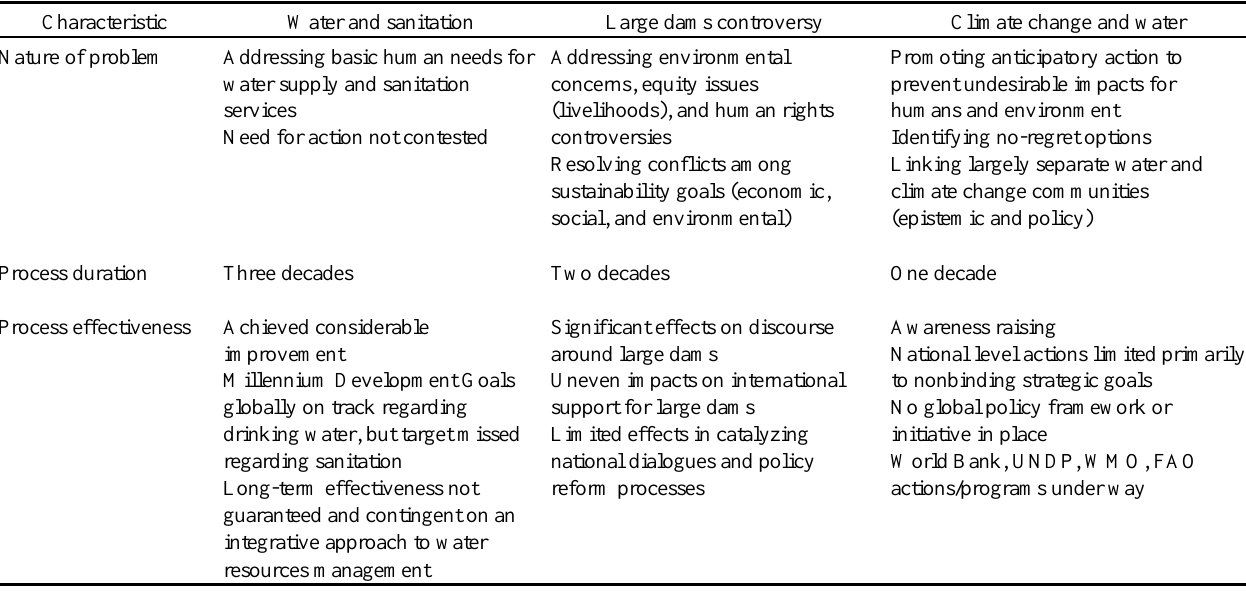
Table 1 . Overall characterization of the three policy